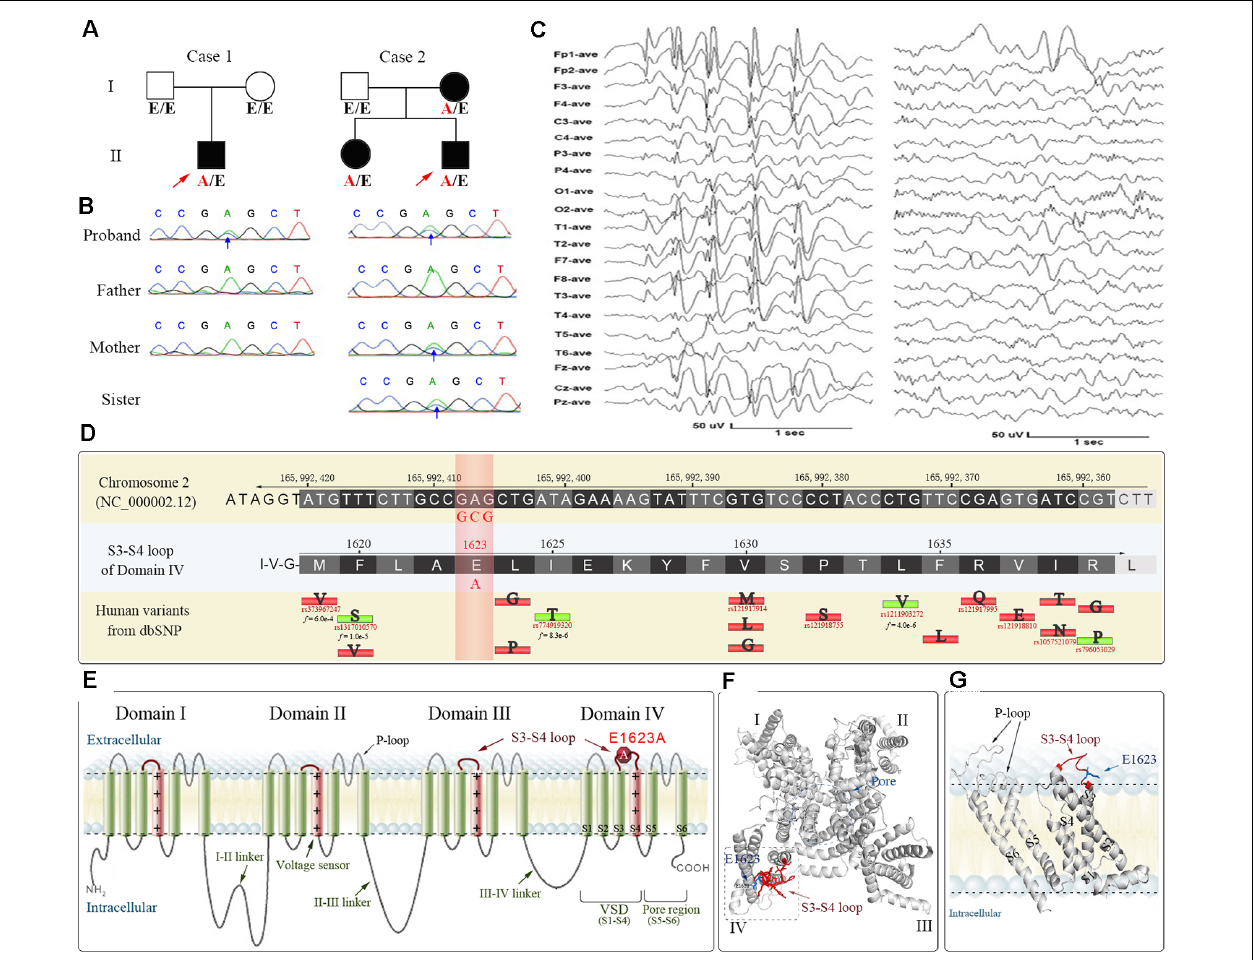
FIGURE 1 | The pedigrees, DNA chromatograms, EEG, and bioinformatical annotations of the E1623A variant of SCN1A gene identified from two cases of epilepsy. (A) Pedigrees of two cases. Case 1 was a 17.5-year-old boy with Dravet syndrome. The proband of case 2 was diagnosed as epilepsy with febrile seizure plus. His mother and elder sister had several febrile seizures before 6 years old. A/E indicates heterozygous E1623A carrier, while E/E indicates wildtype. (B) Sanger sequencing verification. (C) Representative EEG of the case 1 proband showing the generalized high amplitude sharp and slow waves (left), along with focal sharp and slow waves in the left frontal and temporal regions (right). (D) Collection of reference sequences and human variants within the S3-S4 extracellular loop of DIV where the E1623A occurred. The position at E1623 has not been reported with any variant according to human databases. The collected missense variants with epilepsy or non-clinical implications are indicated by red or green bars with their substituted AA abbreviations. Available minor allele frequency ( f value) is under the reference SNP IDs. (E) Structure-function map of Na v 1.1 indicating the location of E1623A. (F) A top view of 3D structural modeling of the Na v 1.1 alpha unit shows that the S3-S4 loop and E1623 were at a distance from the central pore region. (G) A side view of the arrangement of the VSD highlights the extracellular S3-S4 loop and the location of E1623. The S4 helices are depicted in pink, while other helices are in green. The S3-S4 loop is highlighted in